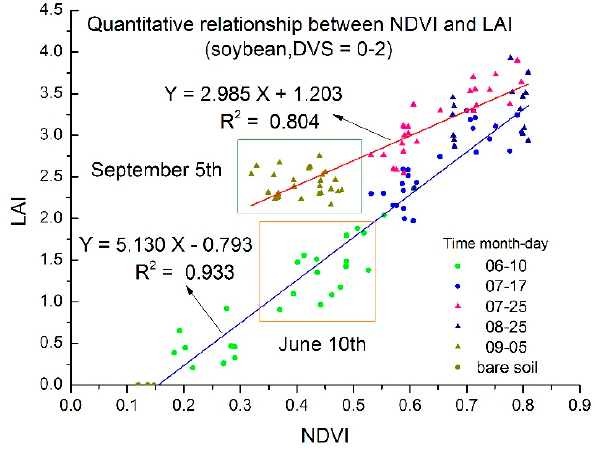
Figure 6. The relationship between NDVI and LAI of soybean in Hongxing Farm.